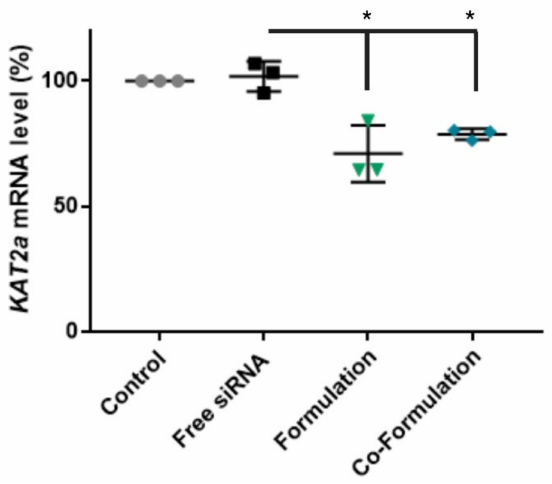
Figure 7. KAT2a mRNA levels after gene knockdown. mRNA levels of KAT2a (as percentage relative to the control (grey dots)) in HL-60 cells measured 72 h post-transfection by TaqMan qPCR and normalized to untreated cells. Mean ± S.E.M of 3 technical replicates performed in triplicate (siRNA: black squares; Formulation: green triangles, Co-formulation: blue diamond). One-way ANOVA with Dunnett’s post hoc test was used. * p < 0.05 compared to untreated